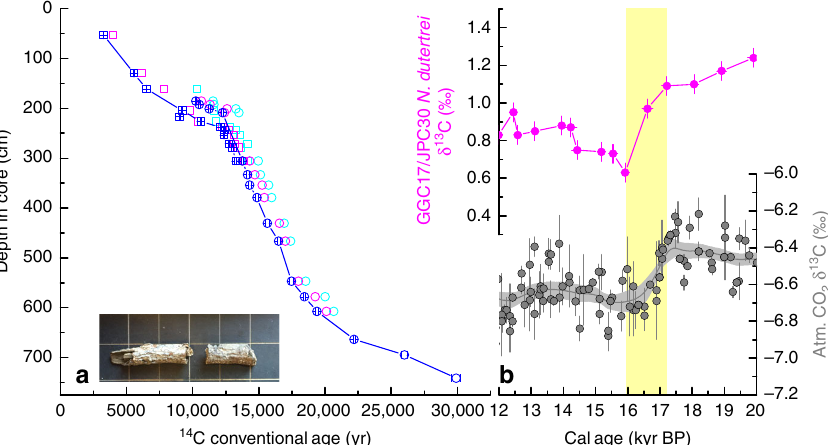
Fig. 2 Wood-based chronology of KNR176-GGC17/JPC30. a 14 C age − depth relationship (blue) of GGC17 (squares) and JPC30 (circles). Most error bars (1 s.d.) are within the symbols. Note the offset of ~30 cm between the two cores due to core-top sediment loss by the piston corer. Inserted is one example of the twigs with bark found in the cores, with 1 cm 2 squares in the background. 14 C ages of N. dutertrei and Uvigerina from the same layers where twigs are present are shown in magenta and cyan, respectively. b N. dutertrei δ 13 C from GGC17/JPC30 (with 1 s.d. on both axes; excluding one anomaly at ~17.4 kyr BP with unknown carbon source (Supplementary Fig. 6)) plotted with the δ 13 C of atmospheric CO 2 reconstructed from ice cores (gray line and shaded area represent the average value and 1 s.d. envelope) 20 . Note that each δ 13 C datum is associated with a wood date. A δ 13 C decrease is apparent from ca. 17 to 16 kyr BP (as delineated by the yellow band) in both records, suggesting that good correlations to high latitudes can be achieved when there is an atmospheric teleconnection Supplementary Fig. 6) supports that our record is representative estimates (655 ± 105 yr; n = 2) and (ii) modern (pre-bomb) of the thermocline and intermediate-depth carbon isotope com- estimates from water-column data 23 for the calcifying depths of N. dutertrei in the EEP 24 (~600 yr; Figs. 1, 3b). Although the positions in the EEP. calendar ages of our samples depend on the 14 C calibration Six estimates of the EEP thermocline reservoir age for the LGM curve 25 , the reservoir ages reported in this study do not because average 670 ± 160 yr, similar to (i) our mid-late Holocene